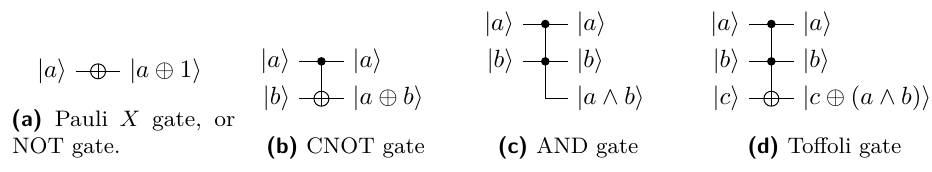
Figure 1: Quantum gates used in quantum implementations of classical circuits